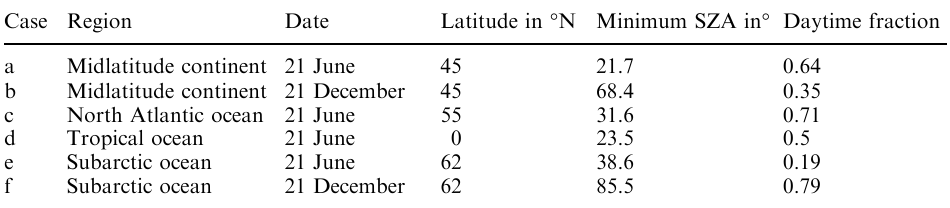
Table 1. Cases (a) to